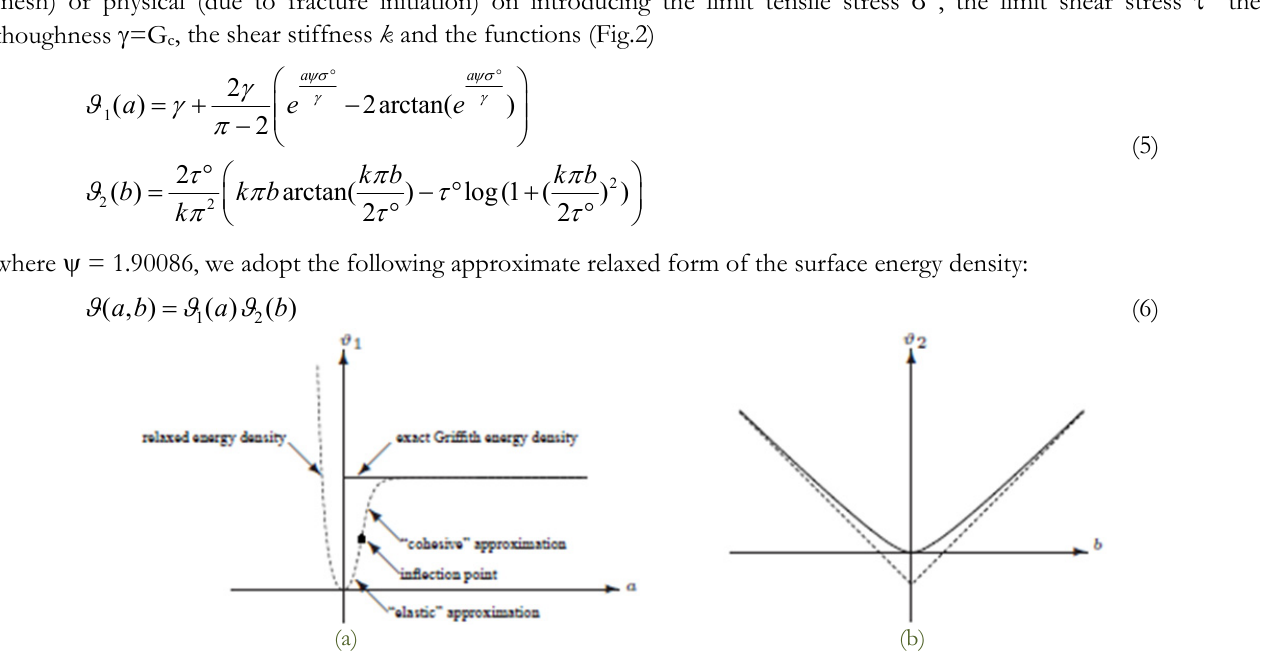
Figure 2: Comparison between exact and relaxed interface